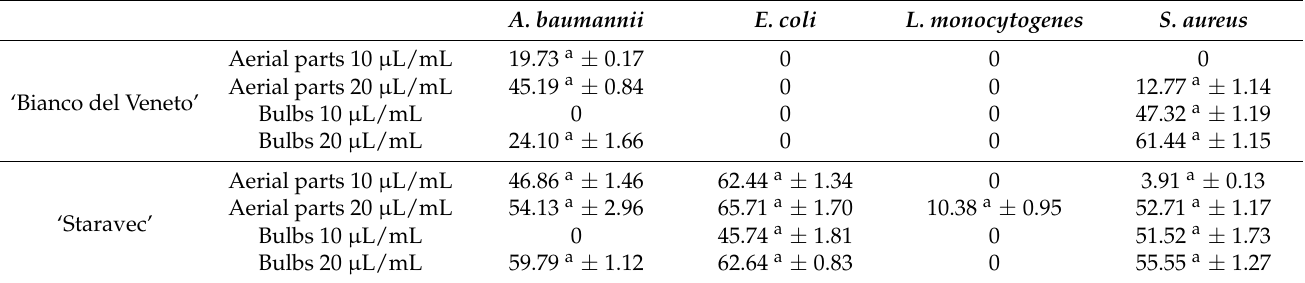
Table 4. Inhibitory activity of the Eos from the A. sativum cultivars on the cell metabolism of the Acinetobacter baumannii , Escherichia coli , Listeria monocytogenes , Staphylococcus aureus within the